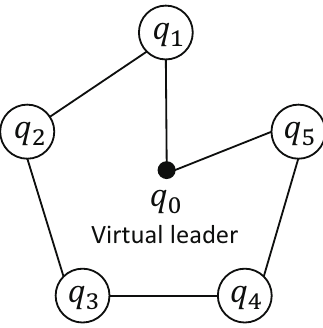
Figure 4. The communication topology